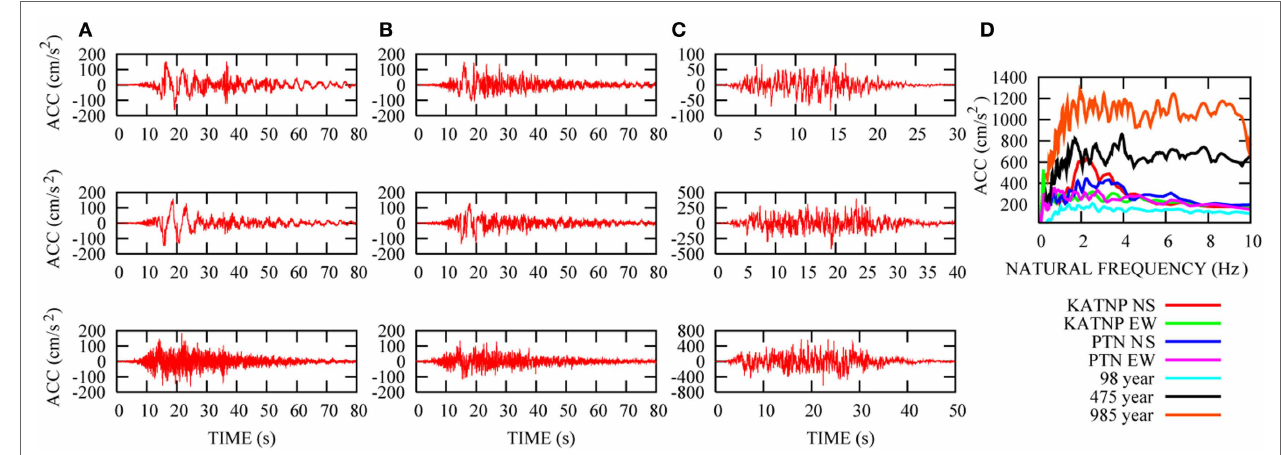
FIGURE 2 | Acceleration record at KATNP and PTN, and probabilistic seismic hazard analysis (PSHA)-predicted ground acceleration (Parajuli et al., 2007; Combined Strong-Motion Data (CESMD), 2016; Takai et al., 2016). (A) Acceleration record at KATNP. (B) Acceleration record at PTN. (C) Synthesized PSHA-predicted ground acceleration for three return periods. (D) Comparison of acceleration response spectra for 5%